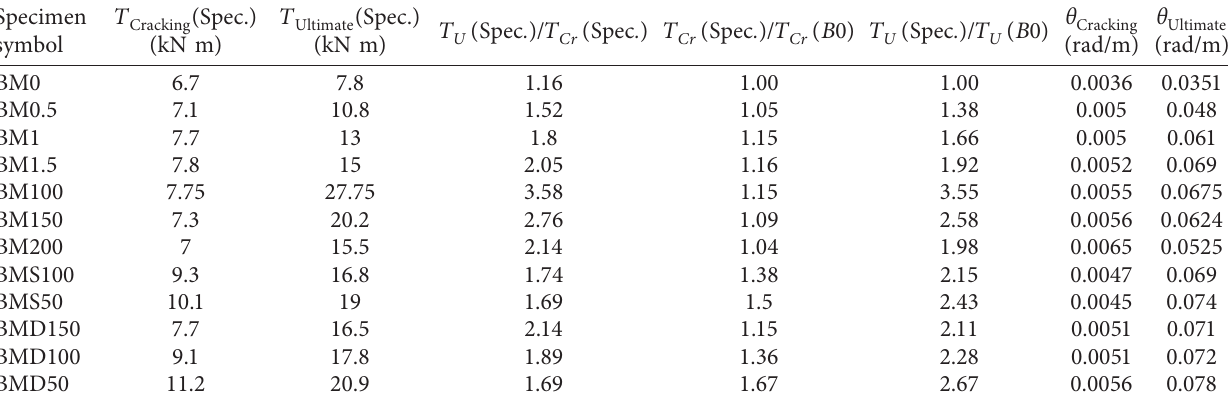
Table 2: Experimental study